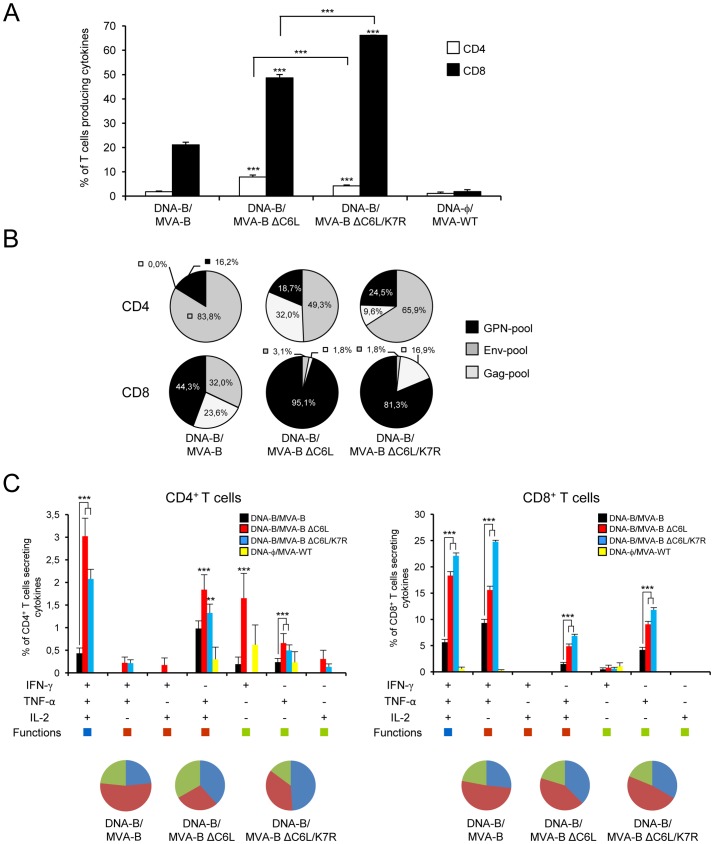
Immunization with MVA-B deletion mutants enhances the magnitude and polyfunctionality of HIV-1-specific CD4+ and CD8+ T cell memory immune responses.Splenocytes were collected from mice (n = 4 per group) immunized with DNA-φ/MVA-WT, DNA-B/MVA-B, DNA-B/MVA-B ΔC6L or DNA-B/MVA-B ΔC6L/K7R 52 days after the last immunization and HIV-1-specific CD4+ and CD8+ T cell memory immune responses were analyzed by flow cytometry as described in Figure 3. Values from unstimulated controls were subtracted in all cases. p values indicate significantly higher responses compared to DNA-B/MVA-B immunization group, and also between MVA-B deletion mutants. Data are from one experiment representative of three experiments. (A) Magnitude of HIV-1-specific CD4+ and CD8+ T cells. The values represent the sum of the percentages of T cells secreting IFN-γ and/or TNF-α and/or IL-2 against Env+Gag+GPN peptide pools. *** p<0.001. (B) Percentage of Env, Gag and GPN HIV-1-specific CD4+ and CD8+ T cell memory immune responses. Frequencies were calculated by reporting the number of T cells producing IFN-γ and/or TNF-α and/or IL-2 to the total number of CD4+ and CD8+ T cells in the different immunization groups. (C) Polyfunctionality of HIV-1-specific CD4+ and CD8+ T cells. Functional profile of HIV-1-specific CD4+ (left panel) and CD8+ (right panel) T cell memory immune responses in the different immunization groups. Responses are grouped and color-coded on the basis of the number of functions. All the possible combinations of the responses are shown on the X axis. The percentages of T cells secreting IFN-γ and/or TNF-α and/or IL-2 against Env+Gag+GPN peptide pools are shown on the Y axis. The pie charts summarize the data. Each slice corresponds to the proportion of HIV-1-specific CD4+ or CD8+ T cells producing one, two or three cytokines (IFN-γ and/or TNF-α and/or IL-2) within the total HIV-1-specific CD4+ or CD8+ T cells. ** p<0.005, *** p<0.001.